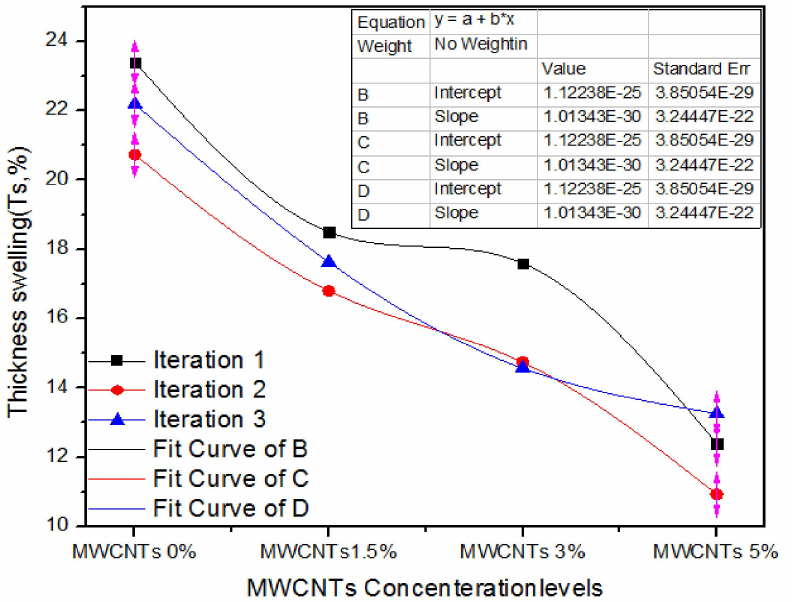
Figure 8. Statistical parameters of thickness swelling of MDF for numerous counts of